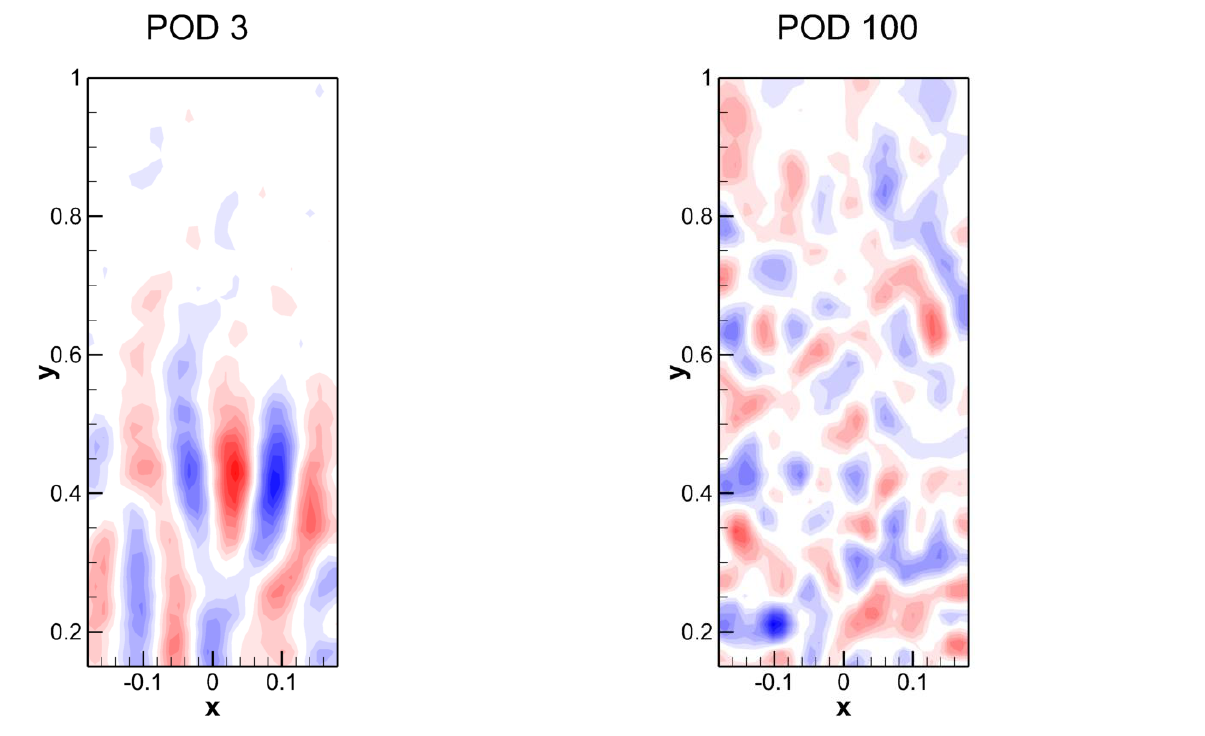
Fig. 20. Vorticity POD mode No. 100, 0.29%